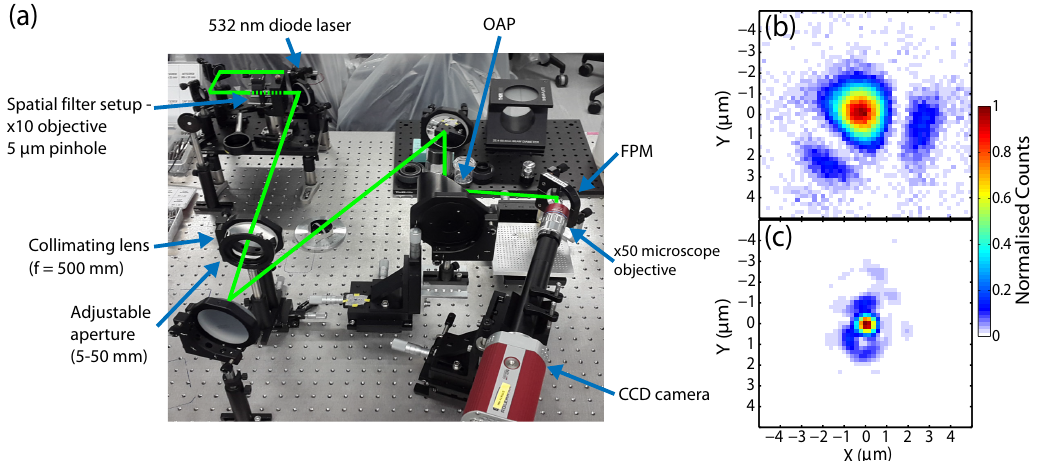
Figure 3. ( a ) Photograph of the experimental set-up developed to characterise the FPMs in non-plasma operation, where the main components are labelled and the laser path is shown in green. Measured focal spot spatial-intensity distributions using the characterisation set-up at: ( b ) f 1 (input focus); and ( c ) f 2 (output